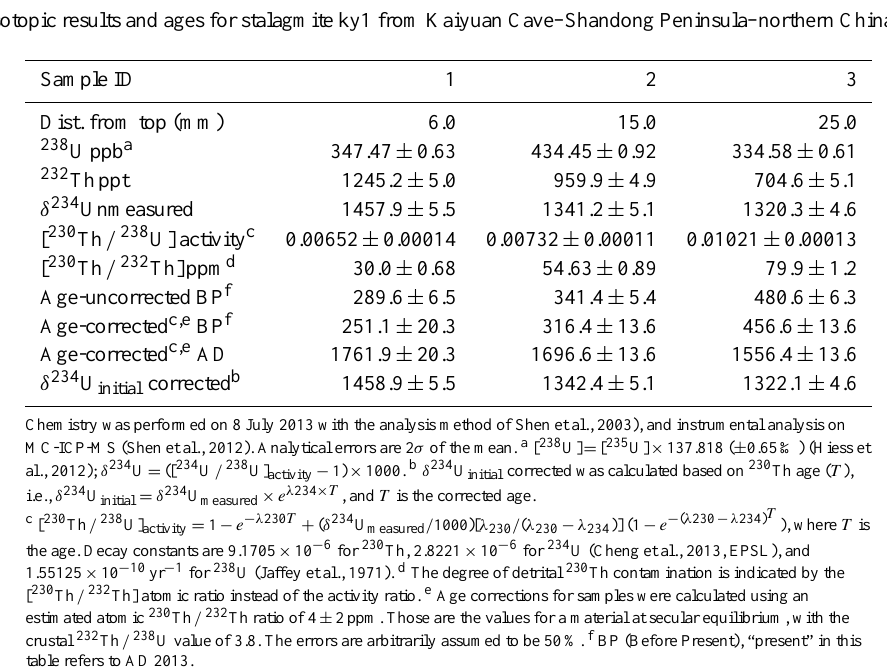
laminae on average according to the three data points for each of the laminae. Fourth, we dated every one of the